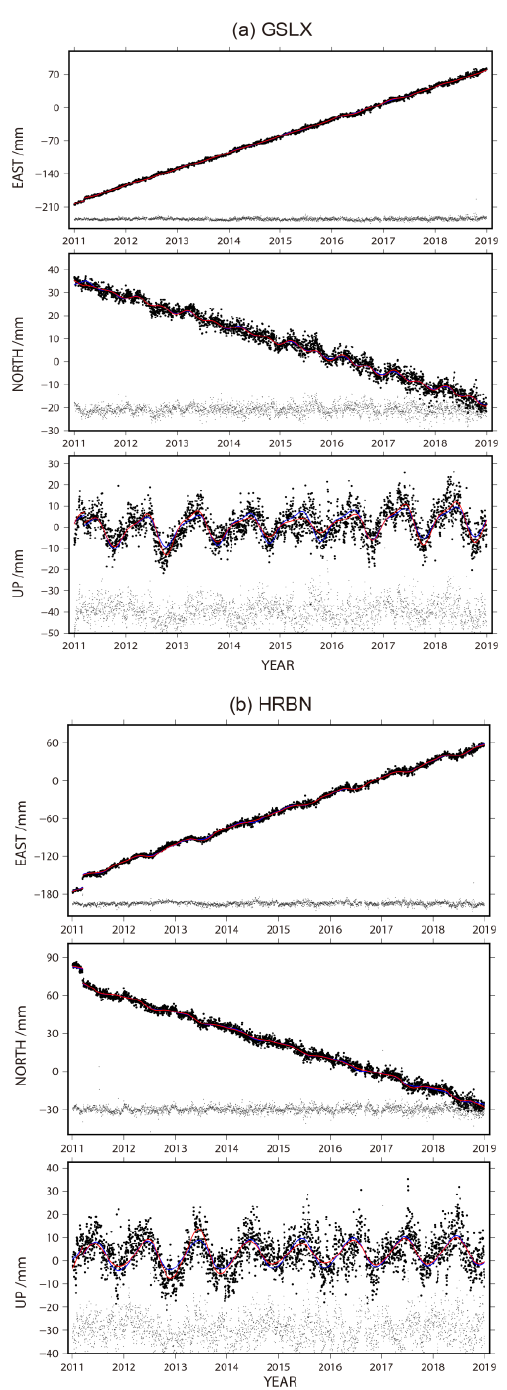
Figure 3 . Time series diagram. the black circles represent the time series of the position, blue curve: fit results of the constant amplitude model, red curve: fit results of the amplitude modulation model. The grey circle represents the filtered residual sequence (the residual sequence is shifted for